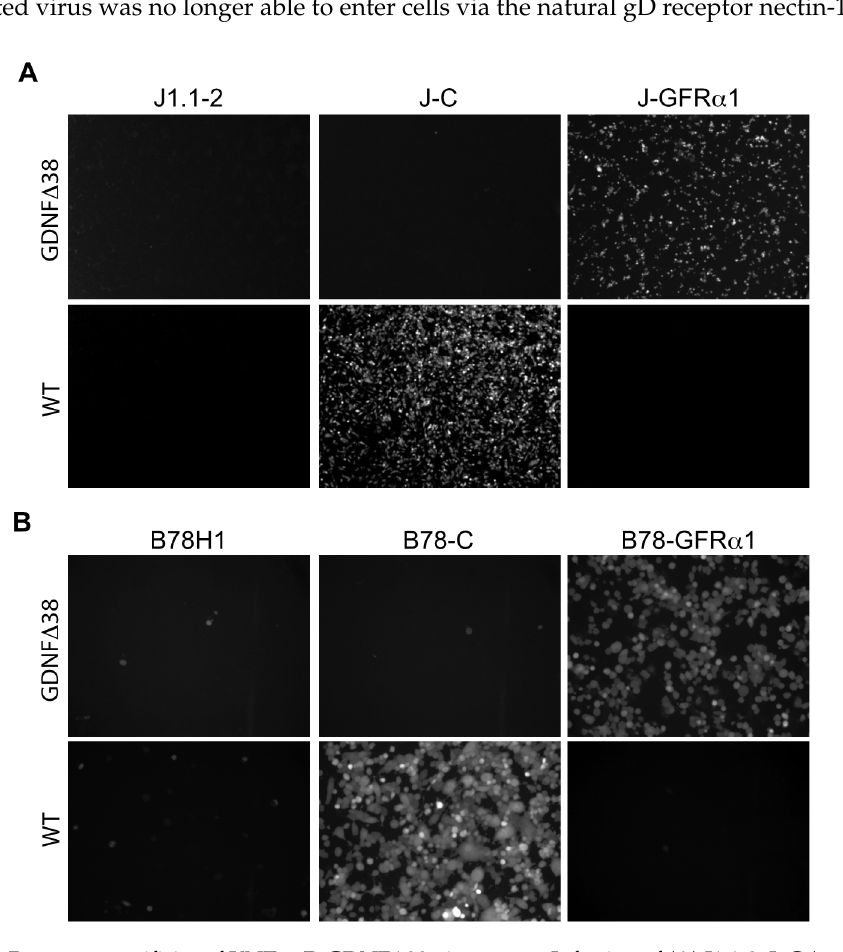
Figure 3. Receptor specificity of KNTc-gD:GDNF Δ 38 virus entry. Infection of ( A ) J1.1-2, J–C (nectin-1 + ) and J-GFR α 1 cells or ( B ) B78H1, B78-C and B78-GFR α 1 cells with KNTc-gD:GDNF Δ 38 and KNTc-gD:wt viruses at 0.5 pfu/cell. Virus entry into cells was visualized as mCherry fluorescence at 24 hpi.